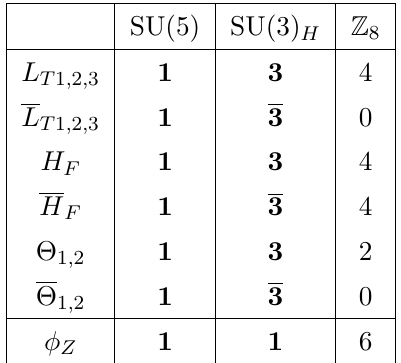
Table 6. Field contents of fermions and a scalar with the Z 2 n charge and pairing fermions for n = 4 . SM lepton doublets are in L T ’s. The Z 8 symmetry is free from anomaly including Z 3 practice, this Z 8 symmetry is equivalent to Z 4